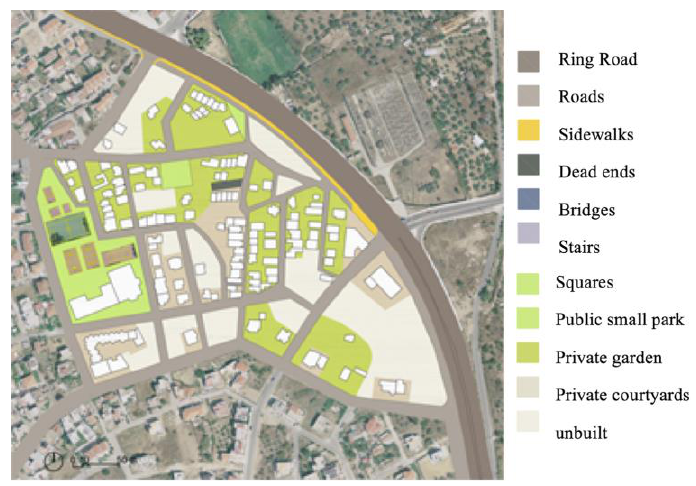
Figure 7. Urban Typology map in Karagats urban area, Volos, Greece.